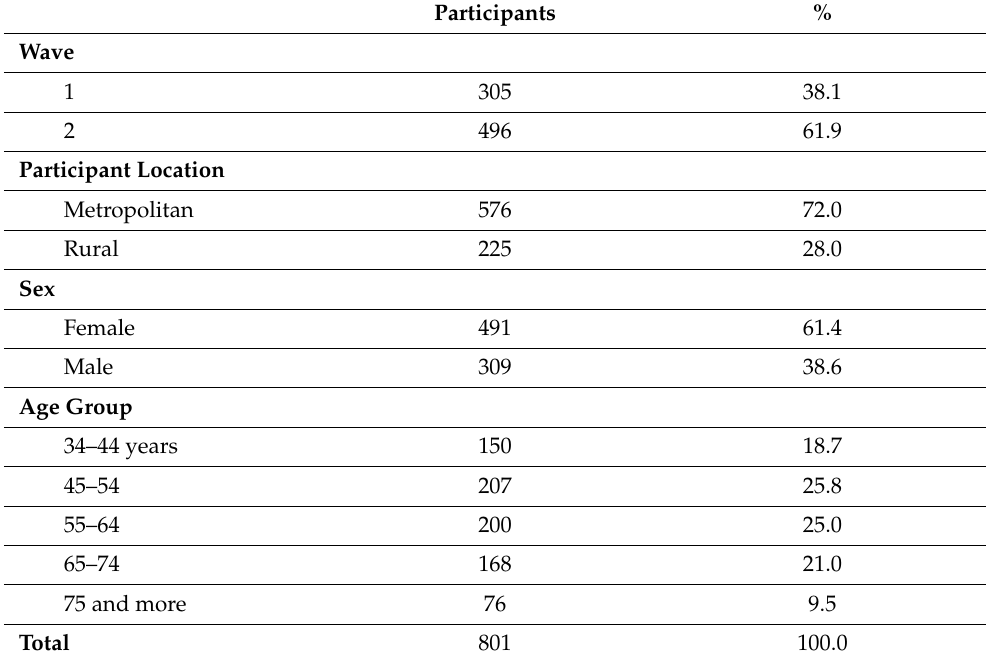
Table 2. Characteristics of the iDENTify study